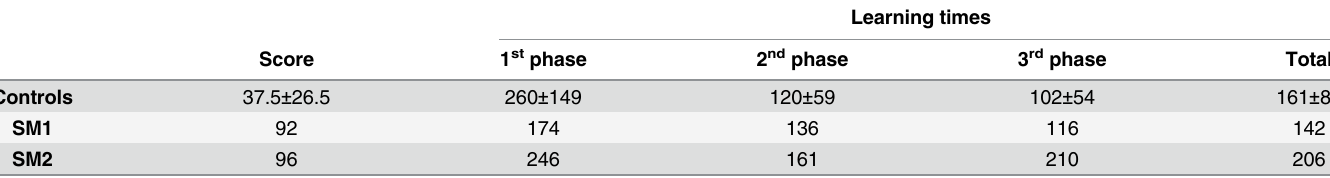
Table 2. Results for Experiment 1: Face-name association learning with naturalistic stimuli.